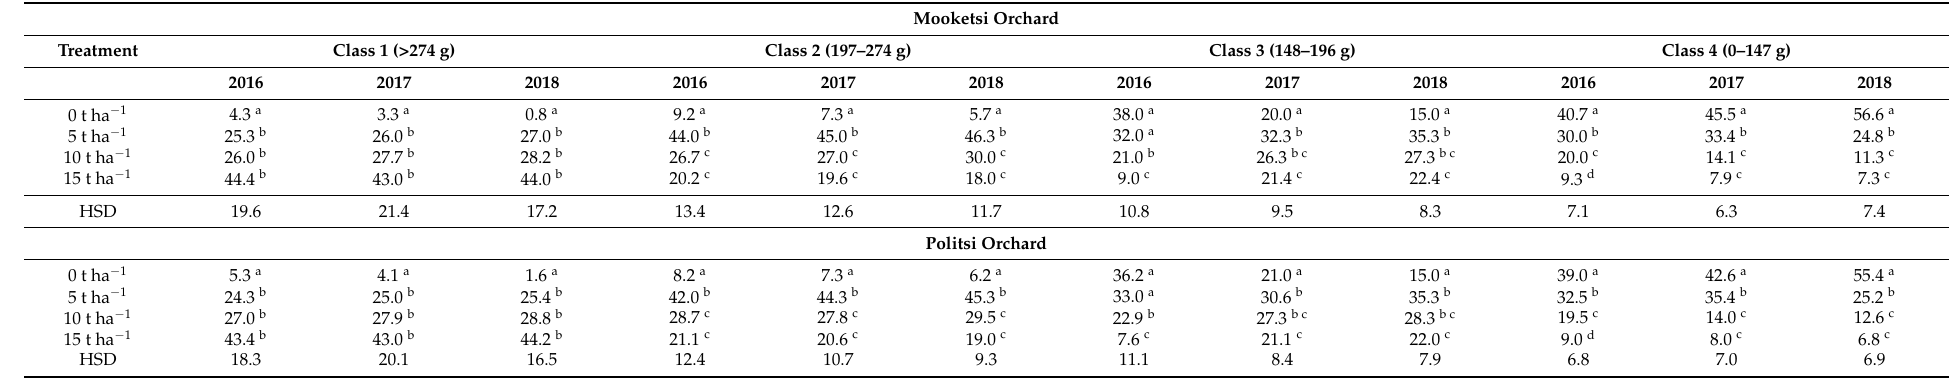
Values followed by the same letter in a column do not differ significantly ( p < 0.05). Table 6. Avocado fruit size distribution (%) as influenced by compost application rates over the three-year study (2016–2018) at the Mooketsi and Politsi orchards.